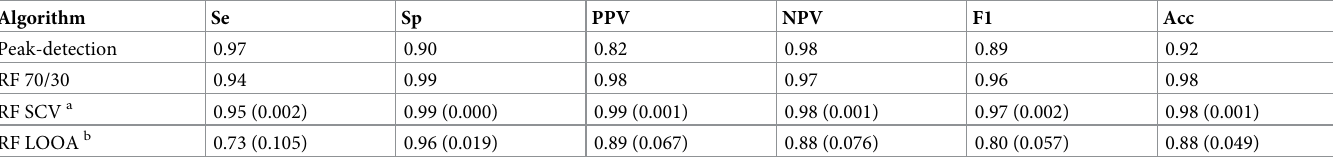
Table 5. Performance of algorithms for rumination. Algorithm